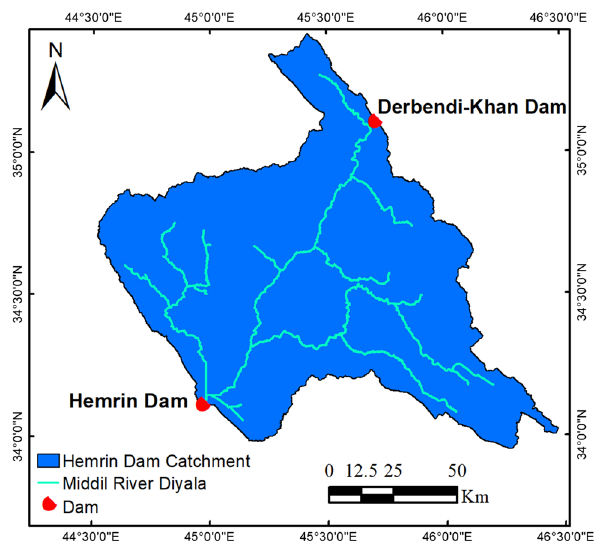
Fig. 3 Hemren dam reservoir catchment area beyond Derbendi-Khan dam.(SRTM